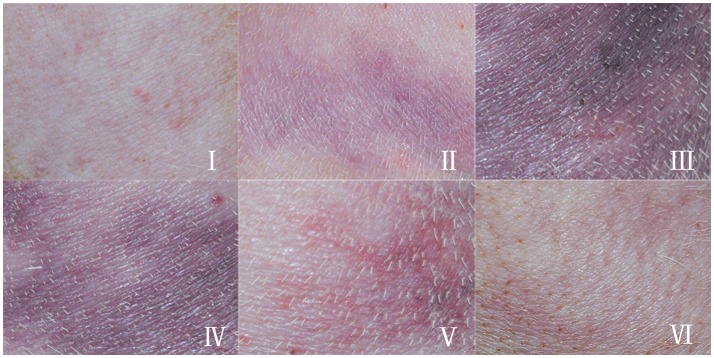
Typical appearance of skin lesions in a swine DCS model. Swine were subjected to a simulated air dive to 40 m for 35 min with a decompression in 11 min, skin appearance were observed and recorded. The hair had been removed prior to the experiment. (I): Erythematous skin, erythematous skin with purple-red discrete macular lesions; (II): Marbling, evolving purple-red marbling; (III): Homogenous purple-red lesion, purple-red homogenous, macular lesion; (IV): Fading lesion, purple-red or blue-black shrinking, and fading macular lesion with reappearance of marbling; (V): Scattered lesion, blue-black scattered, and fading macular lesion; (VI): Remnant, faintly visible blue-black discrete macular lesion.